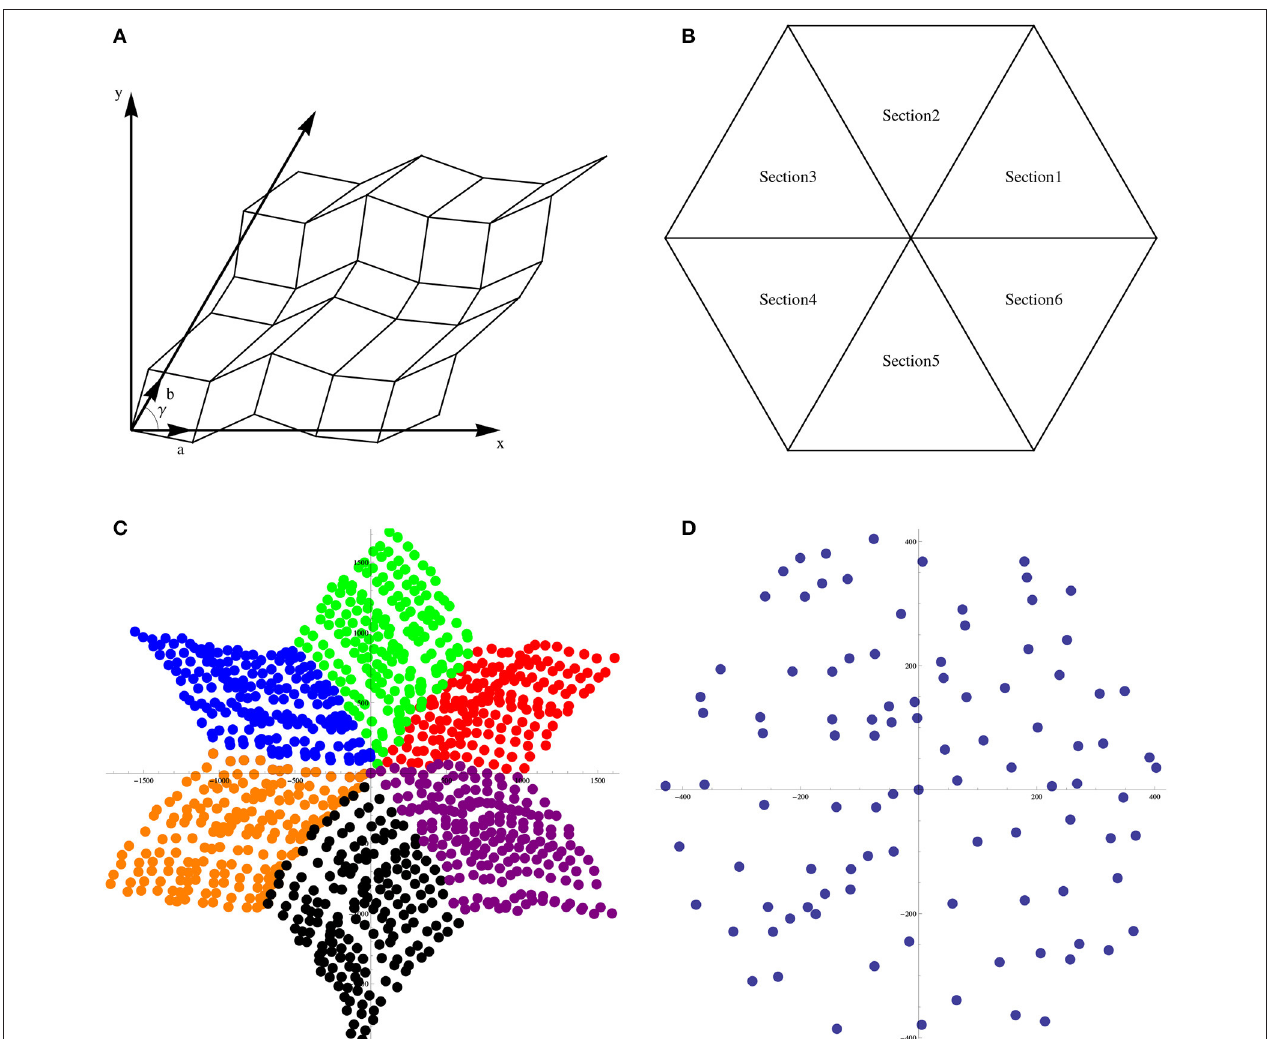
FIGURE 6 | Construction of hexagonal paracrystalline lattice model – parallelogram-based 2D paracrystal model (A) , space of paracrystalline lattice divided into six sectors (B) , lattices built up across sectors (C) , hexagonal paracrystalline lattice model used in simulations (D) .